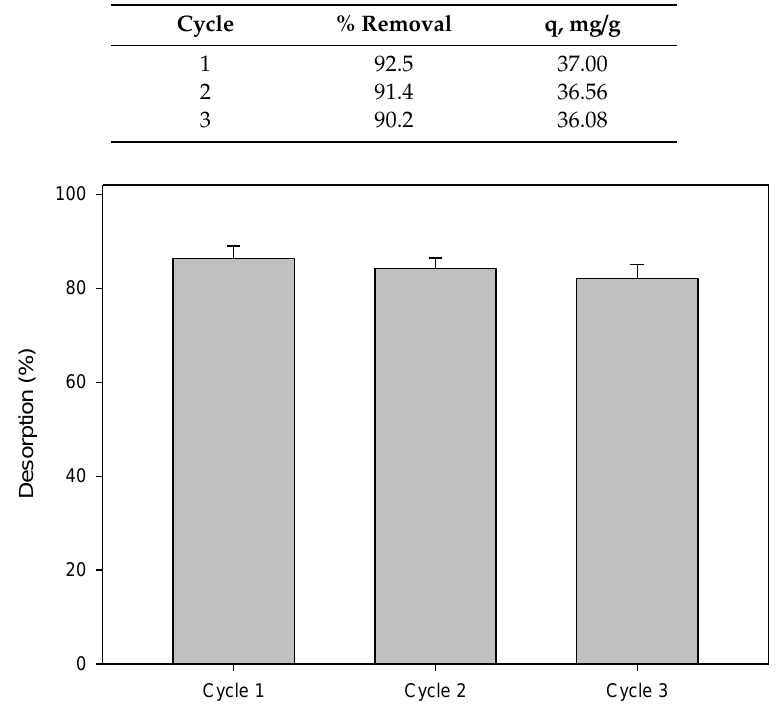
Table 8. Removal e ffi ciency and adsorption capacity of BPA adsorption in three consecutive cycles.